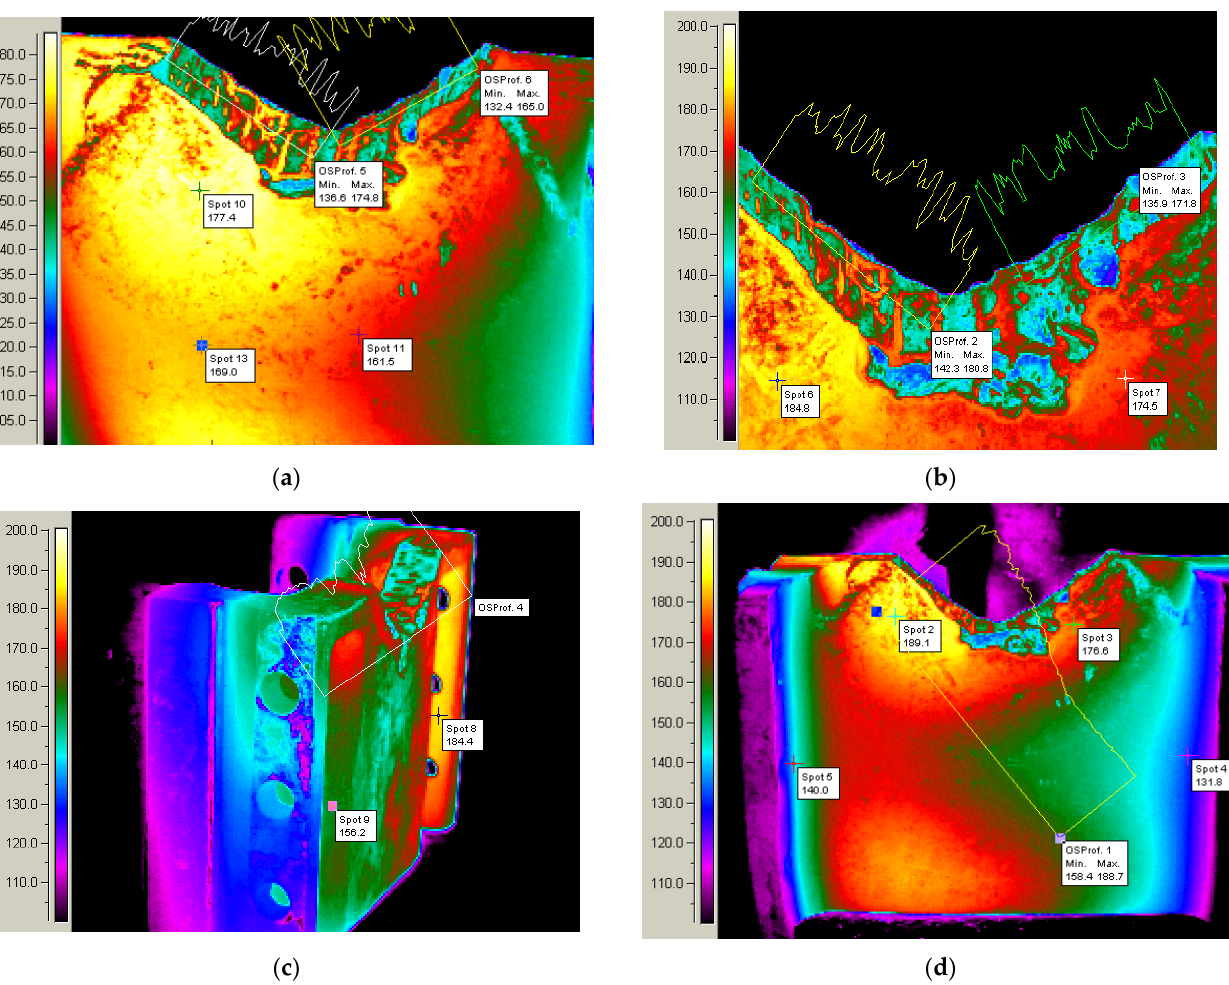
Figure 7. Distribution of temperatures when heating the trimming die. ( a )—side view of the temperature distribution in the material in the active area of the trimming die, ( b )—front view of the temperature distribution in the material from the active area of the trimming die, ( c )—side view of the temperature distribution of the base material of the trimming die, ( d )—front view of the temperatures distribution of the basic material of the trimming die.